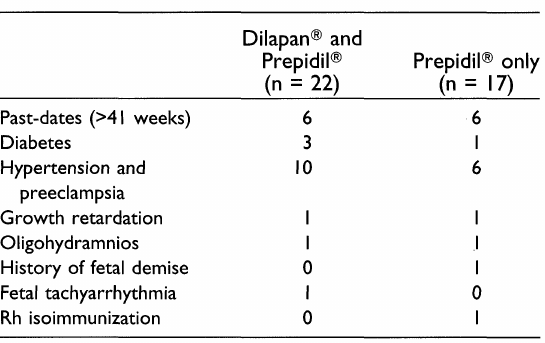
Dilapan (R) and Prepidil